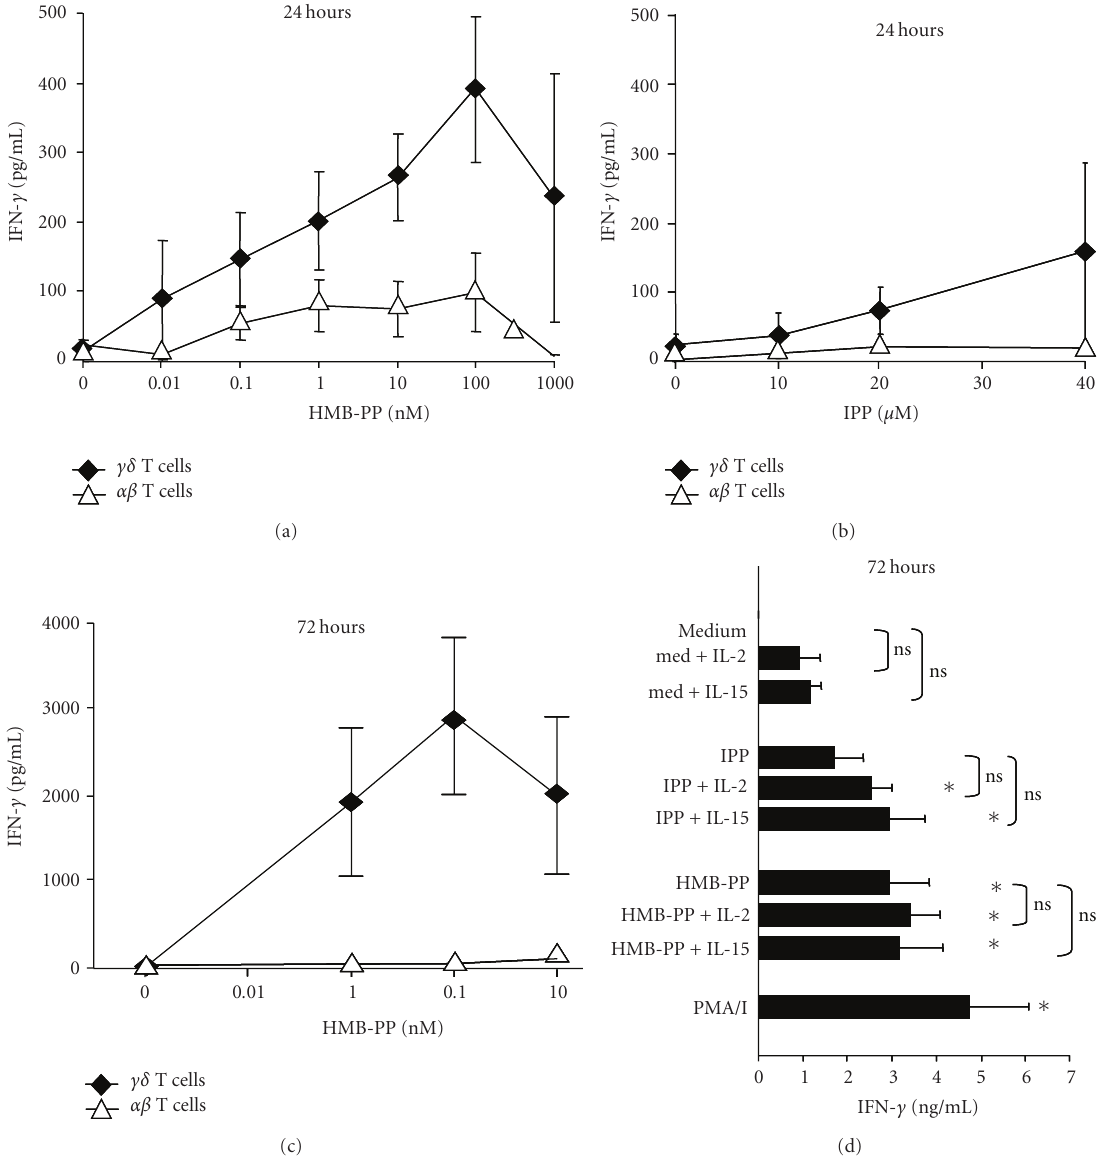
Figure 3: IFN- γ production in response to HMB-PP is restricted to γδ T cells and is highest 72 hours after simulation. Freshly isolated PBMCs were enriched for αβ and γδ T cells using magnetic beads, and 200,000 cells of each population were stimulated with various concentrations of HMB-PP (a and c) or IPP (b). The levels of IFN- γ in cell supernatants were quantified by ELISA after 24 hours (a and b) or 72 hours (c). Results are expressed as mean ( ± SEM) levels of IFN- γ released by αβ and γδ T cells from 2–8 donors. (d) Mean ( ± SEM) IFN- γ production by γδ T cells from 8 donors after stimulation with 10 μ M IPP, 10nM HMB-PP, 50U/mL IL-2, and/or 10 ng/mL IL-15 as indicated. ∗ P < . 05 compared to unstimulated cells (medium). ns: not significant comparing absence and presence of IL-2 and